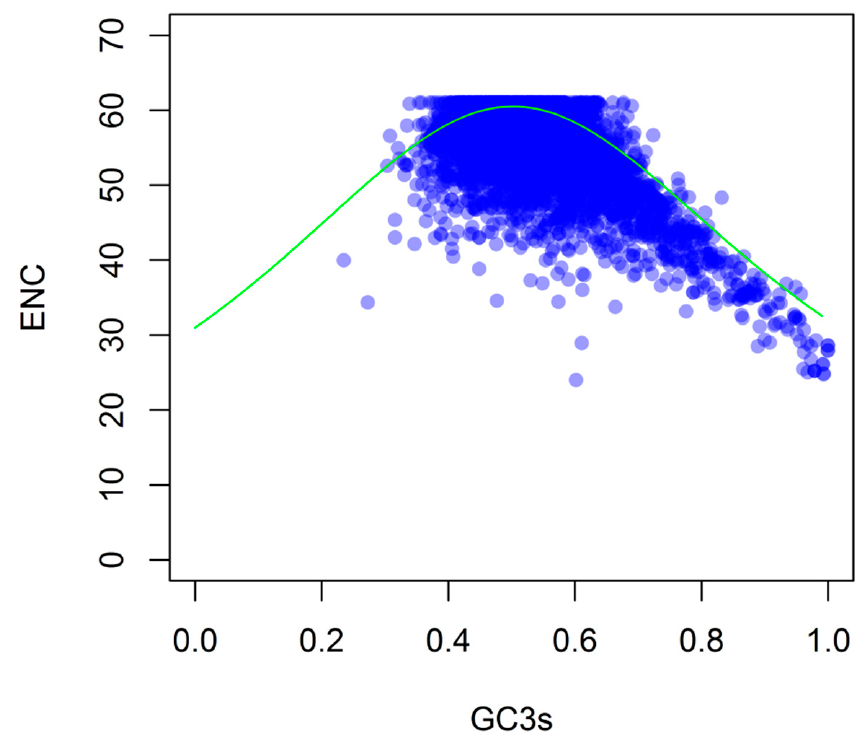
Figure 3. Distribution of ENC and GC3s of G. duodenalis genes. ENC is plotted against GC3s. The solid line (green) shows the expected ENC value if the CUB is caused by GC3s only. (ENCexp-ENCobs)/ENCexp was calculated to estimate the observed and expected ENC values more accurately. We found that (ENCexp-ENCobs)/ENCexp was mainly lo- cated in 0–0.05, and the values of most genes were located in − 0.05–0.15 (Figure 4). The results suggested that the ENCs of most genes were slightly different from the expected ENCs values in GC3s. The observed ENCs values of most genes were near expected ENCs in GC3s, although the ENCs values of some genes were much lower.